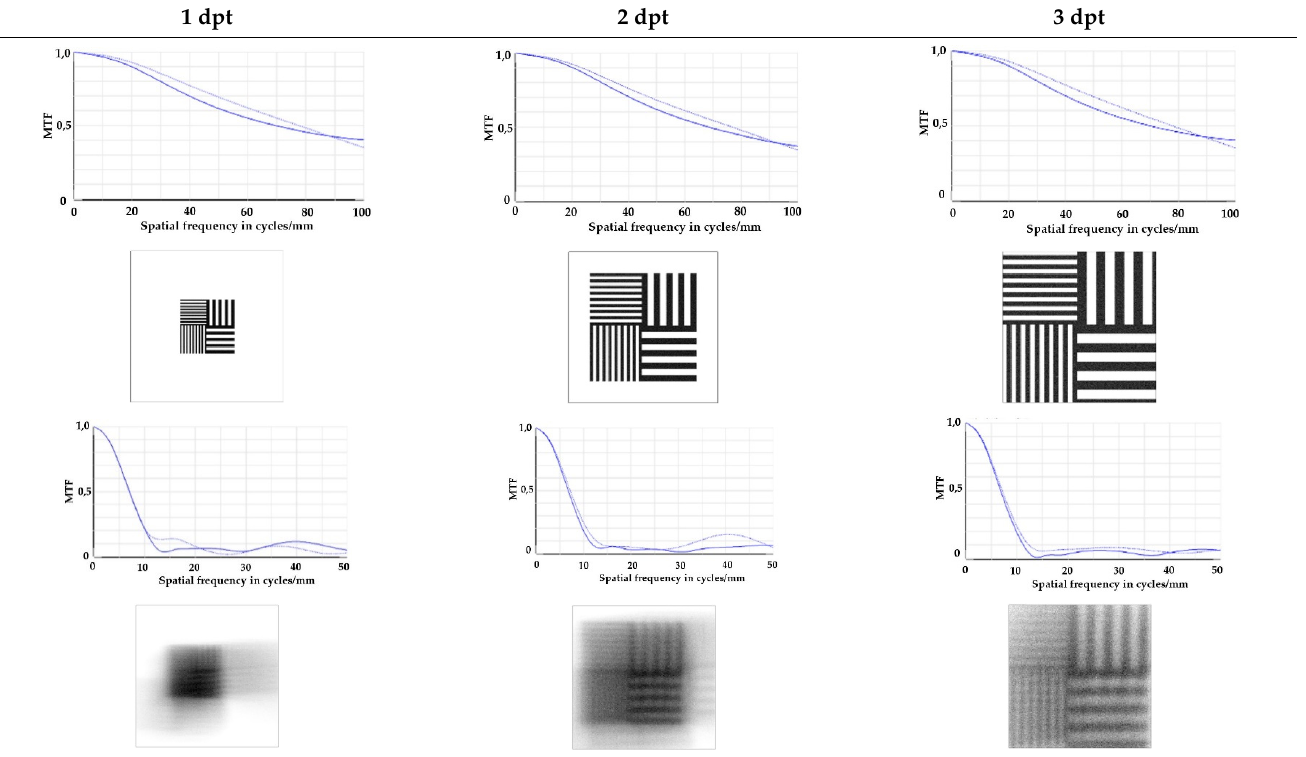
Table 1. The modulation transfer function (MTF) and geometric image analysis of three different adjustments of the rotation optics (1, 2, and 3 dpt) for the nominal surface (first row) and the measured data (second row). 1 dpt